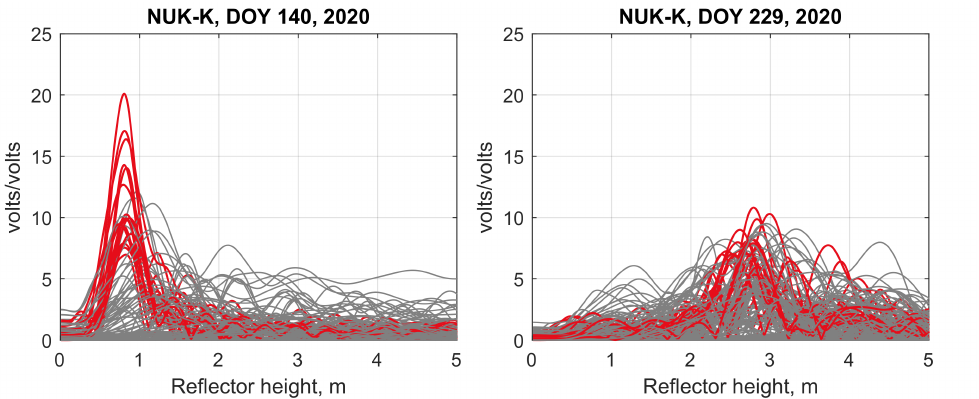
Figure 5. Periodograms from the GNSS-IR extractions of all tracked frequencies on day 140 ( left ) and 229 ( right ). The grey lines are satellite tracks that are discarded in the QC process and the red lines are tracks that are